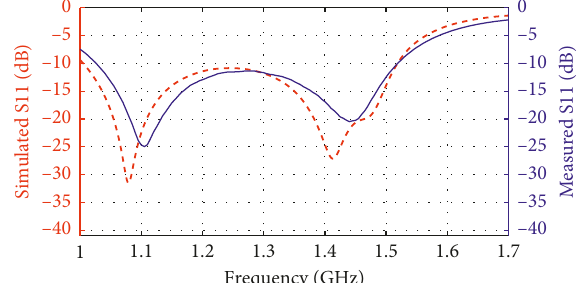
Figure 10: Theoretical and experimental S